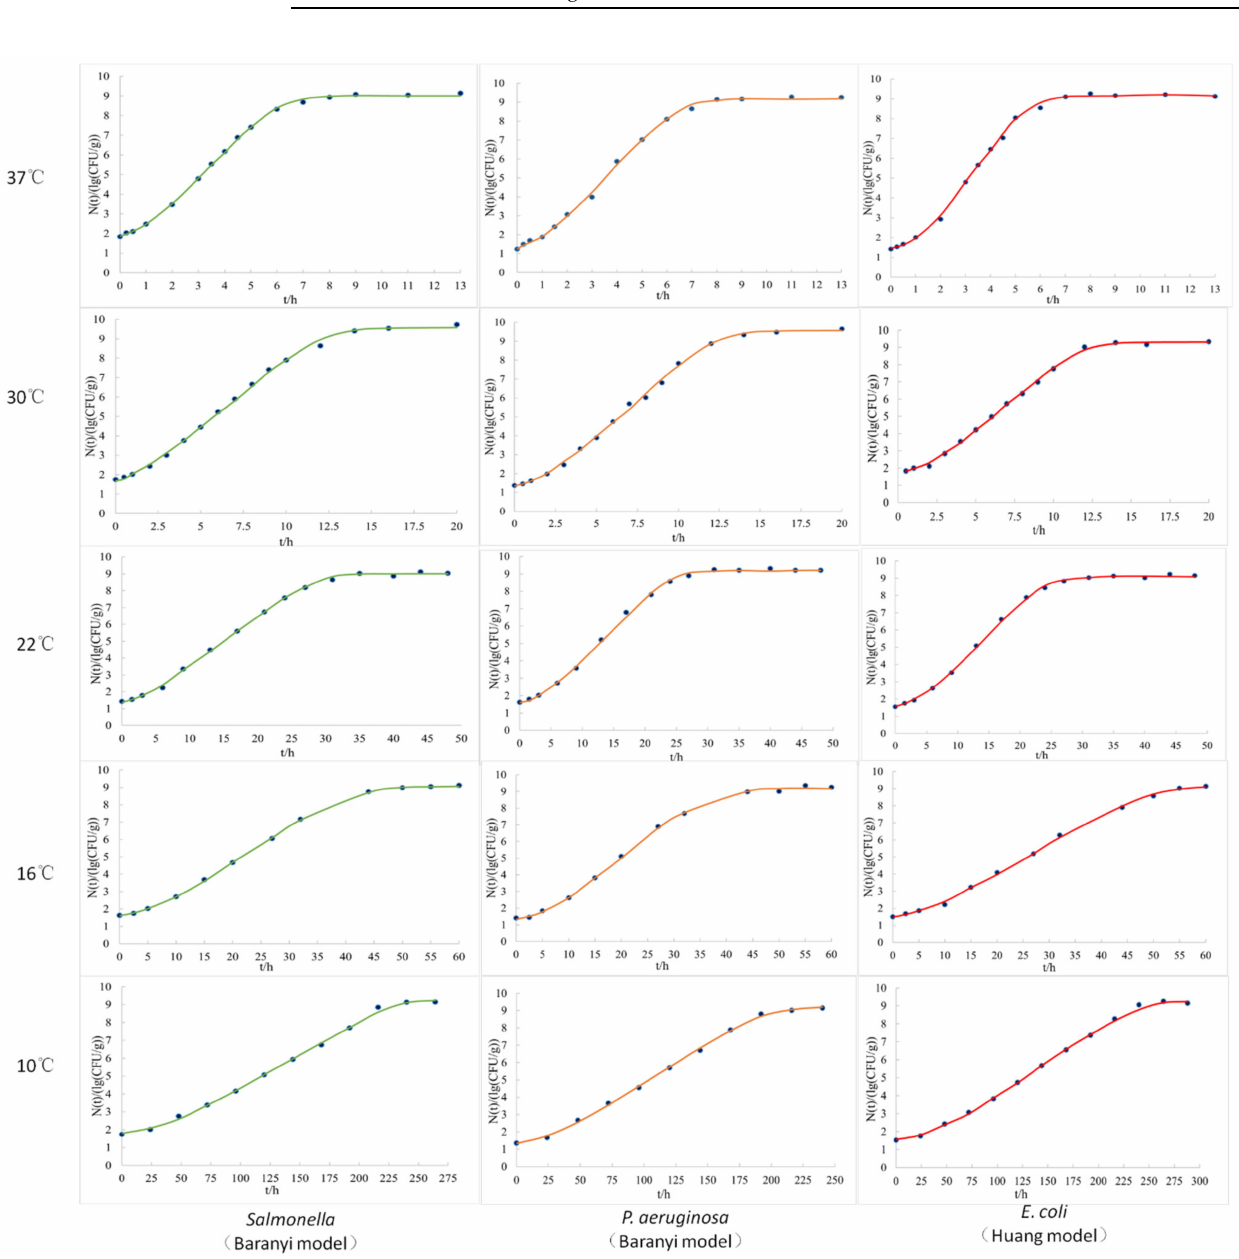
Figure 1. Growth curves of S. Derby, P. aeruginosa , and E. coli in fresh pork at different temperatures fitted by the corresponding optimal predictive